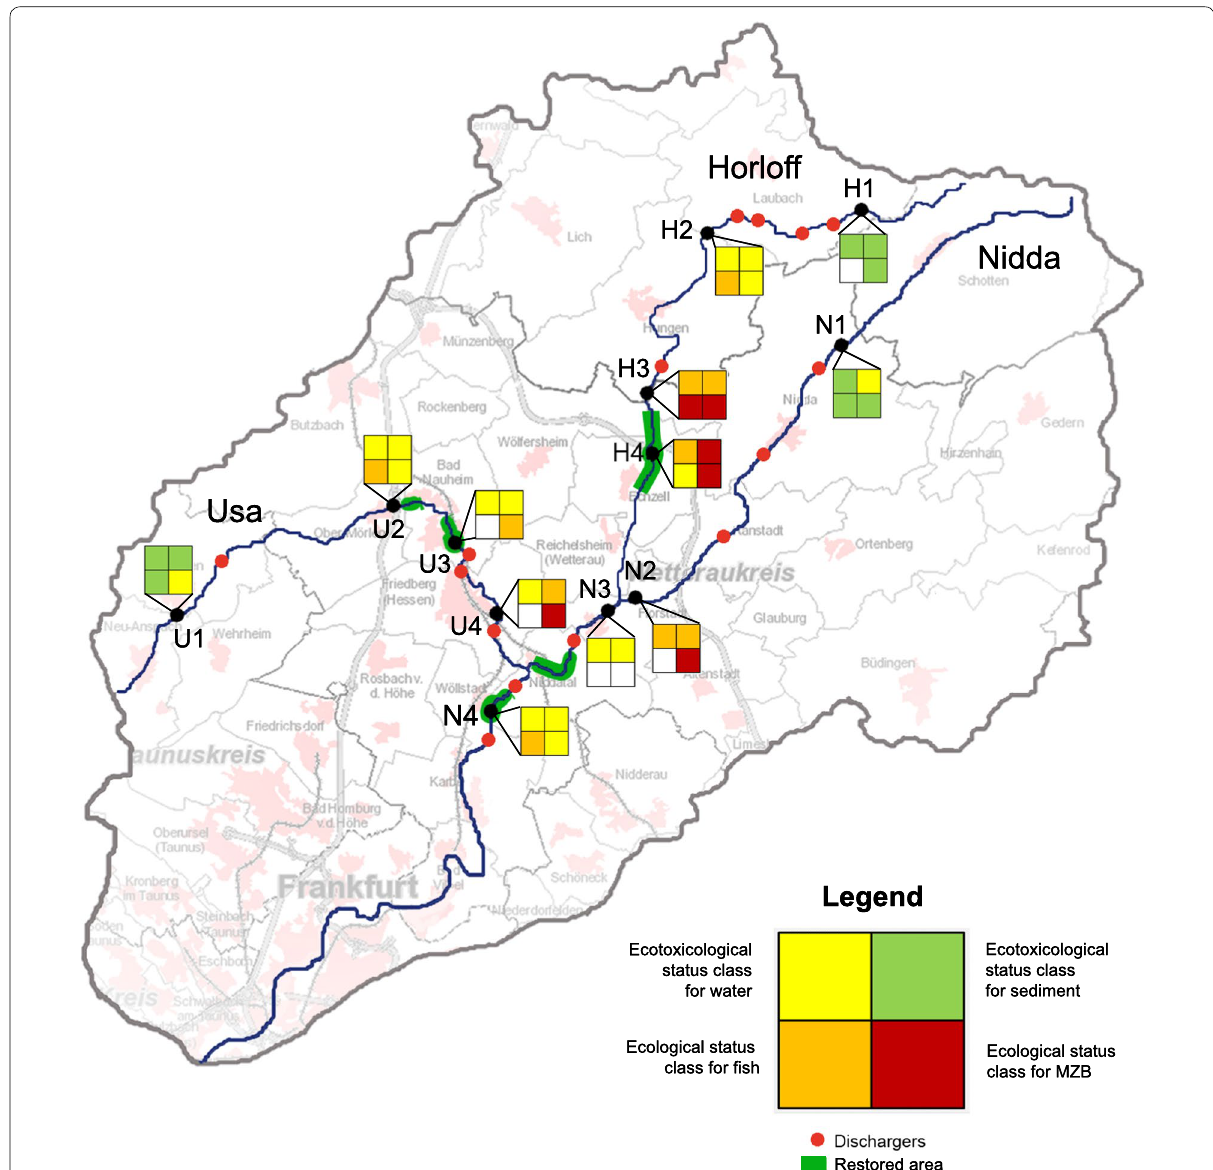
Fig. 5 Map of the Nidda catchment with derived ecotoxicological status classes and ecological status classes for fish and macrozoobenthos (MZB) according to HLNUG [50, 51]. Green: good status (class 2), yellow: moderate status (class 3), orange: poor status (class 4), red: bad status (class 5), white: no HLNUG data for fish or MZB available. Red spots mark dischargers from WWTPs, public baths and a paper mill, green lines restoration areas. The map was modified with Adobe ® Photoshop CC (Version 20.0.0, Adobe Systems Incorporated, San José, California, US) and is based on WRRL‑Viewer